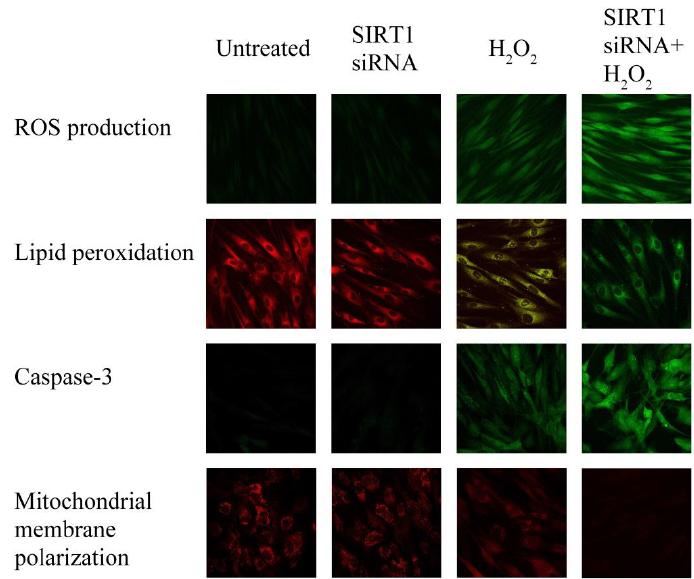
Figure 6. SIRT1 effects in oxidative stress protection. ROS production, lipid peroxidation, caspase-3 activity and mitochondrial membrane polarization were measured by confocal microscopy (63× magnification) in untreated and in SIRT1 siRNA-treated control fibroblasts, challenged or not with H 2 O 2 (500 µM for 3 h) to elucidate the role of SIRT1 in oxidative-mediated cell injury. Fibroblasts were obtained from healthy skin ( n = 4 biopsies). These parameters were measured in untreated and in SIRT1 siRNA-treated control fibroblasts, challenged or not with H 2 O 2 (500 µM for 3 h).